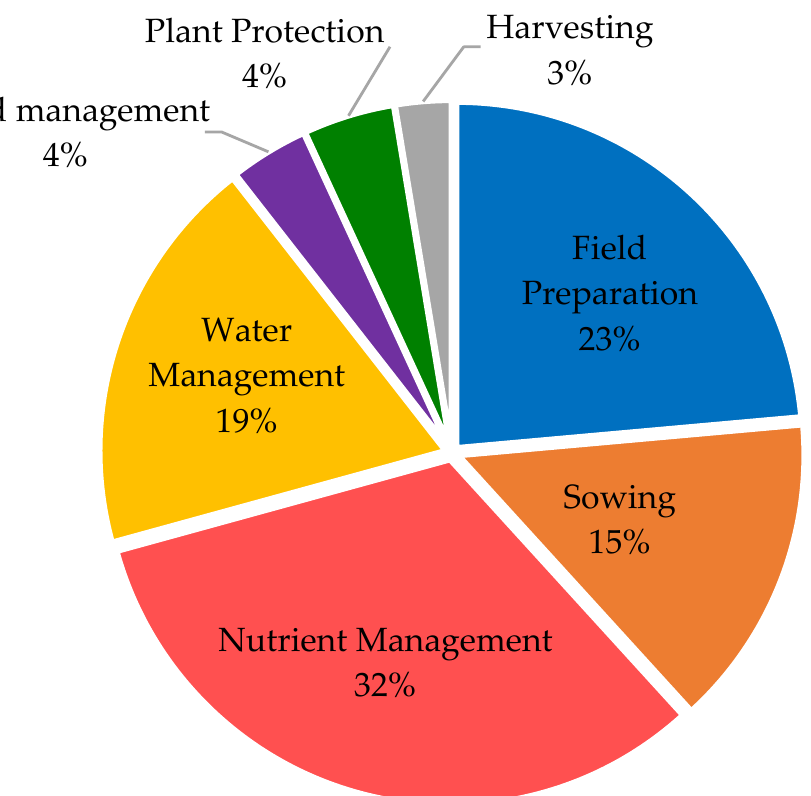
Figure 5. Operation-wise mean share of inputs energy used for fodder maize (mean of two years).